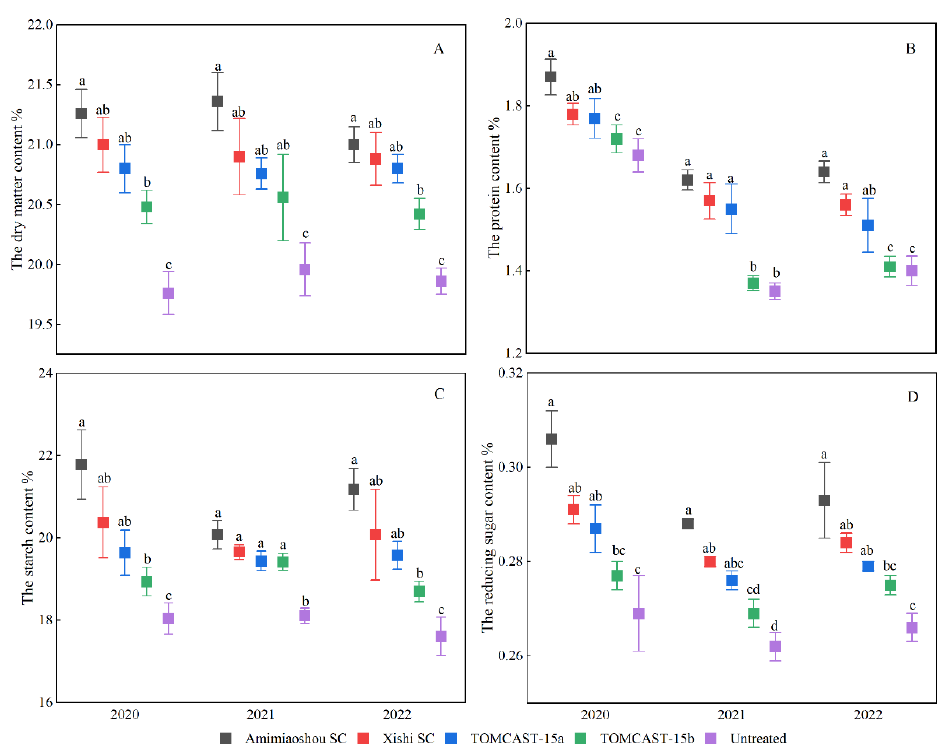
Figure 4. Comparison of potato dry matter ( A ), starch ( C ), protein ( B ), and reducing sugar ( D ) con- tents from 2020 to 2022. Each point represents the mean of five replicates, and error bars associated with each point represent the standard error. The same letter on each point indicates no significant difference between different treatments in the same year and vice versa, according to LSD’s honestly significant difference ( p < 0.05). Table 4. Mean tuber yield of different fungicide schedules from 2020 to 2022.